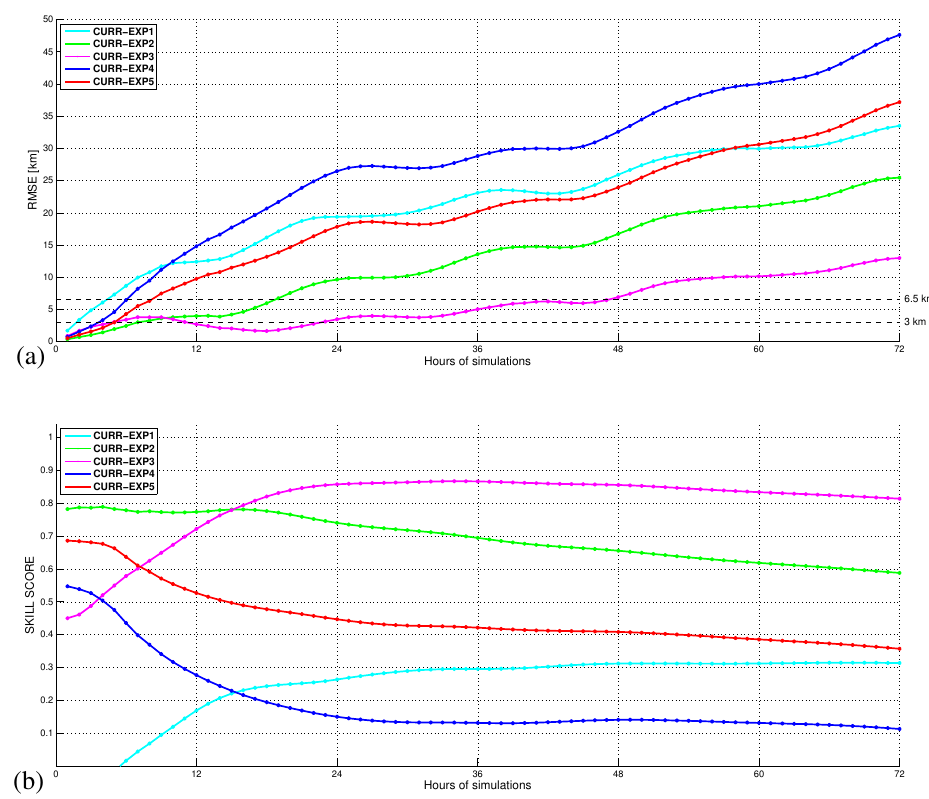
Fig. 3. RMSE (a) and skill score (b) between the observed and simulated trajectories of Fig. 2 as a function of the prediction time.